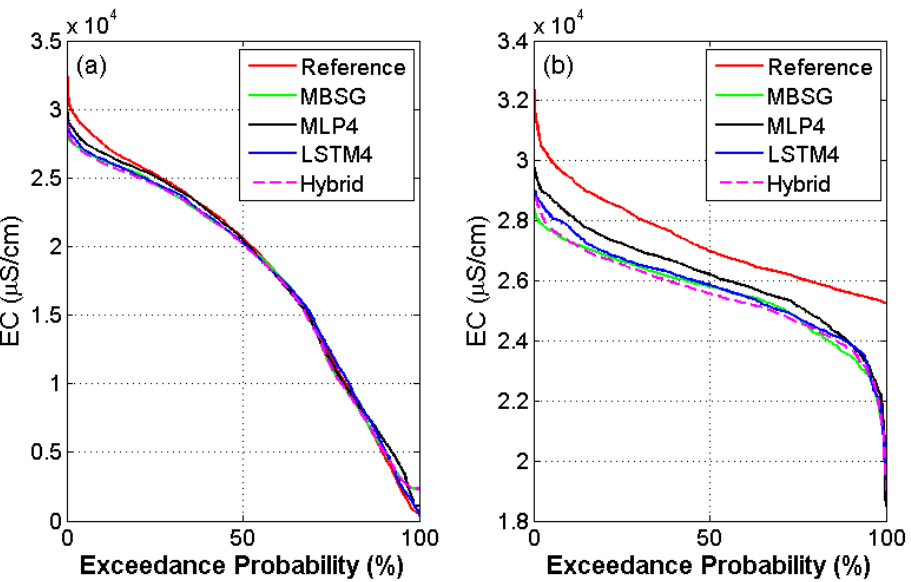
Figure A2. Correlation between daily Martinez salinity and lagged Martinez stage as well as net Delta outflow.